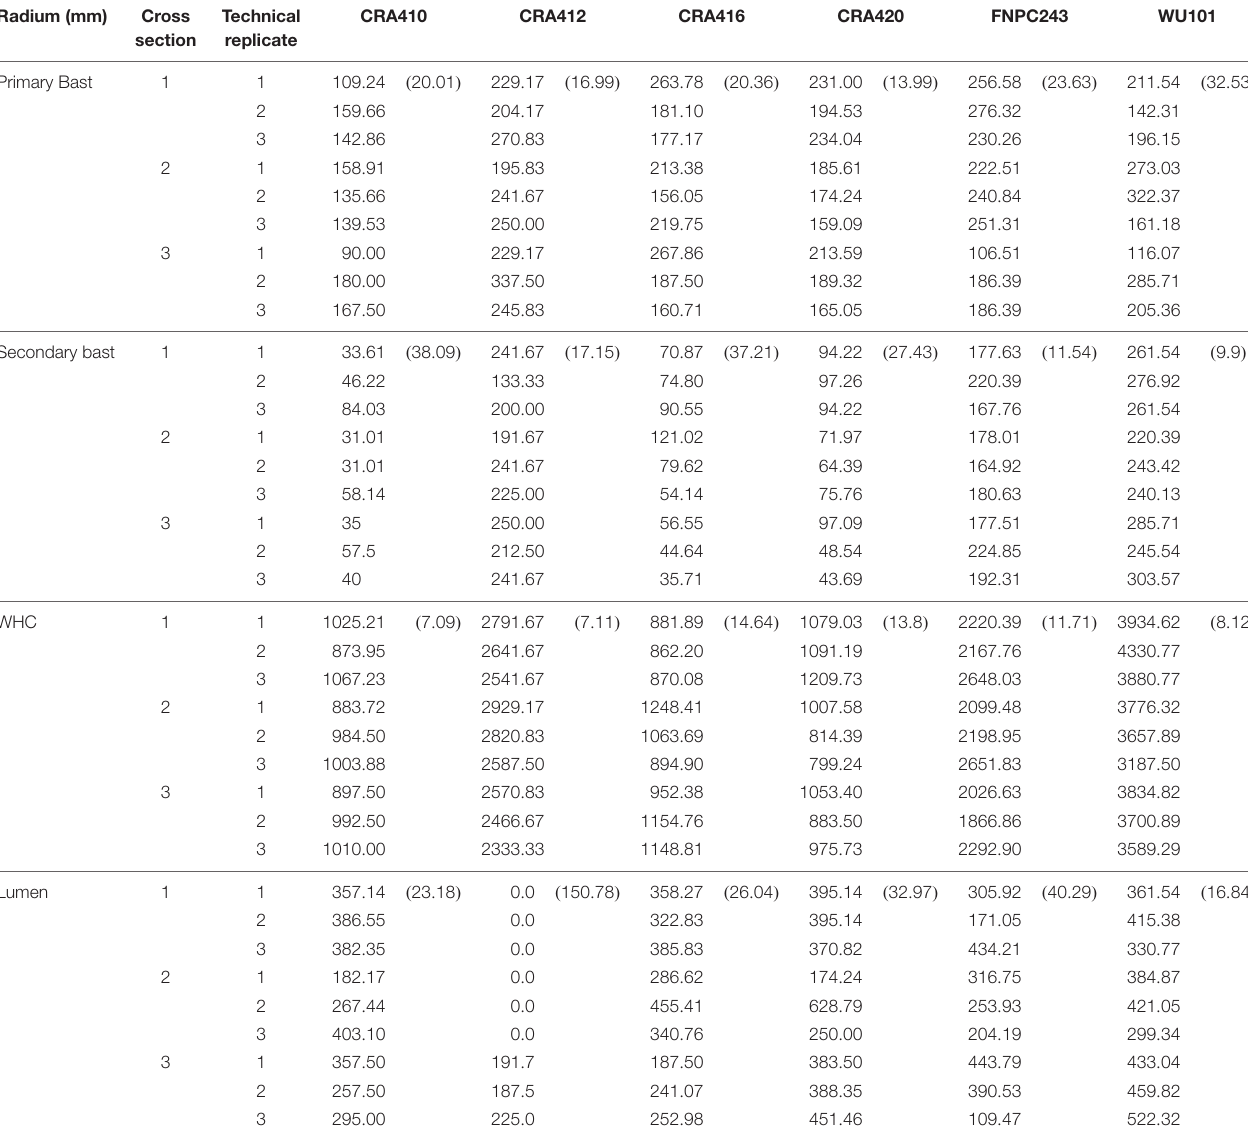
TABLE 6 | Radium (in mm) of the primary and secondary bast fiber, woody hemp core (WHC), and lumen from the cross-sections of hemp stems. Radium (mm) Cross Technical section